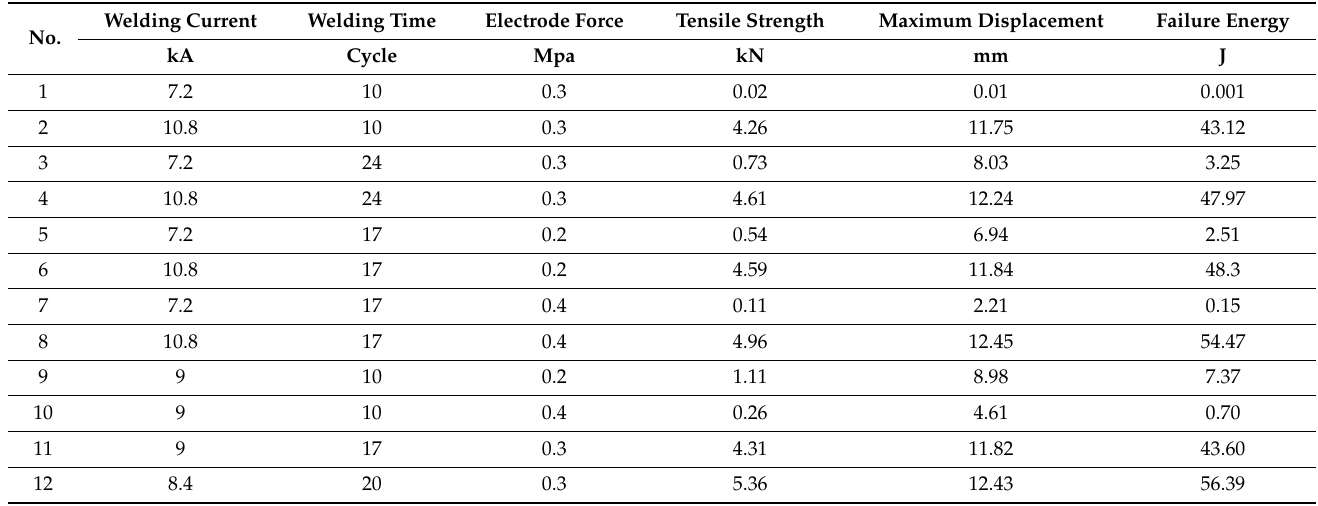
Table 3. The results of the trial